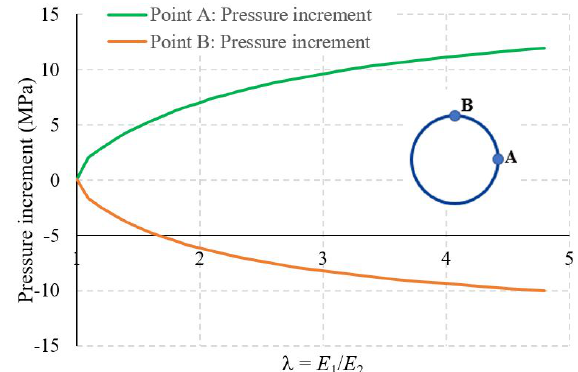
Fig. 7. Pore pressure increment at two points A ( θ = 0 or π ) and B ( θ = π /2 or 3 π /2)